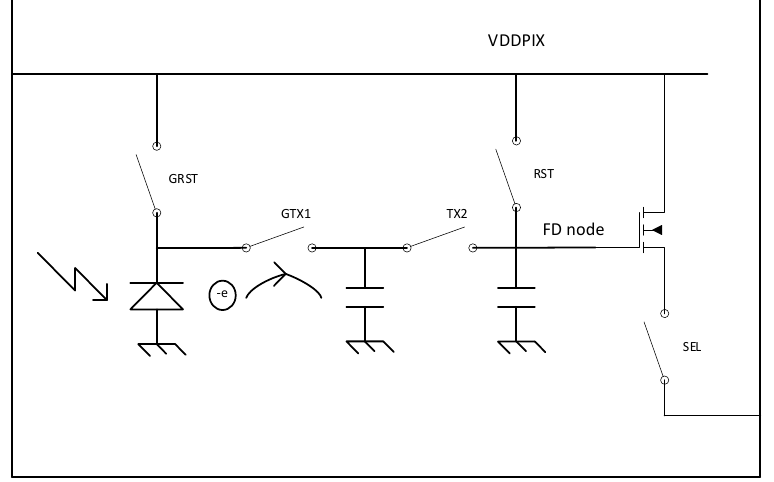
Figure 5. Simplified circuitry of a low-noise GS 6T pinned-pixel. Reproduced from E2V [16]. The notion that the above GS pixel is related to a low-noise light-to-charge structure has to do with the fact that the resulting photo-signal comes free from KTC reset noise power in the readout chain, as the light-induced signal is well/fully correlated with the reset level signal, previously left in the FD